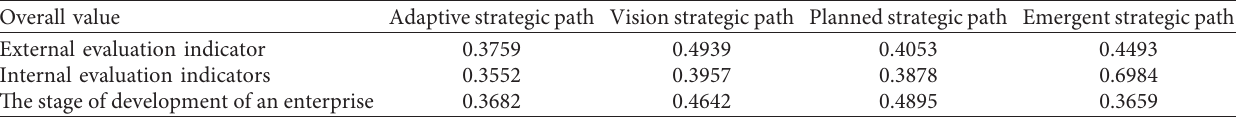
Table 8: Total evaluation value table of path selection for ARR to promote intelligent